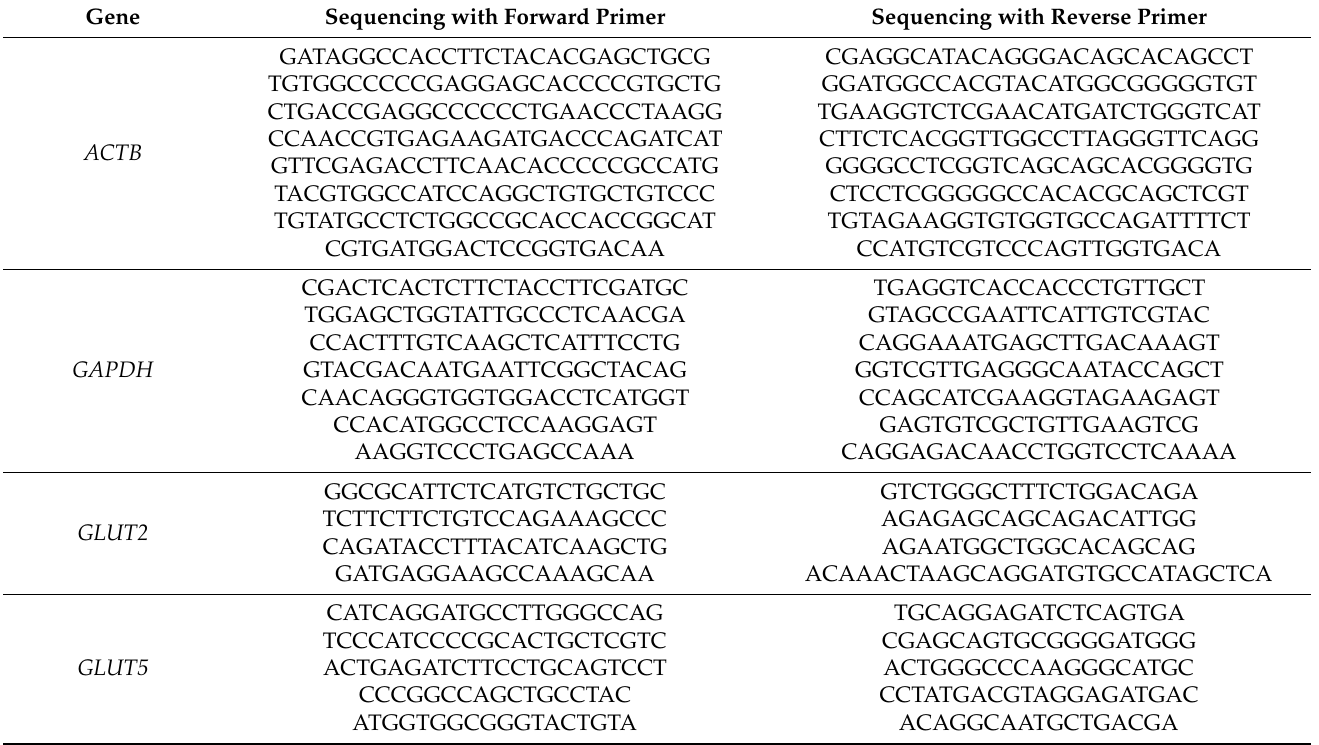
Table 2. Results of sequencing of selected primer pairs for the investigated